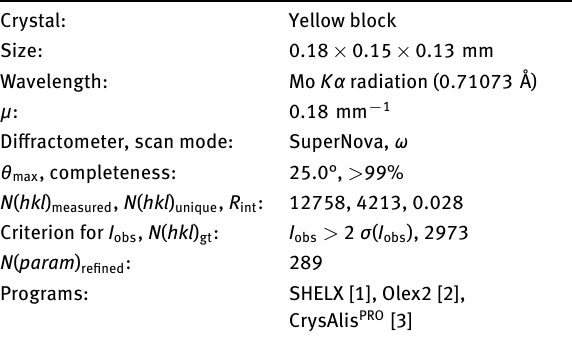
Table 1: Data collection and